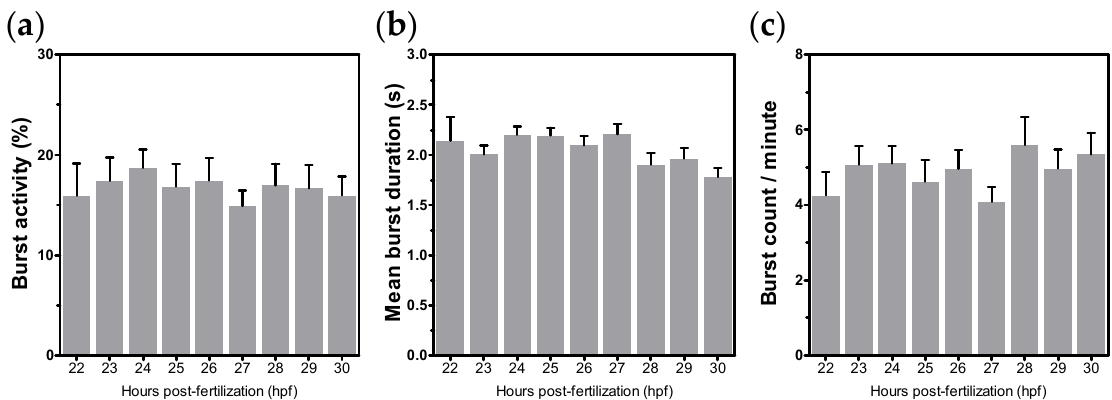
Figure 3. Monitoring of tail coiling activity throughout embryonic development from 22 to 30 h post-fertilization (hpf) at hourly intervals. ( a ) Percentage (%) of burst activity; ( b ) mean burst duration (seconds); ( c ) burst count per minute. Each bar represents a different group of 80 embryos divided into two independent experiments. Values are expressed as means (bars) and 95% confidence intervals (error bars).